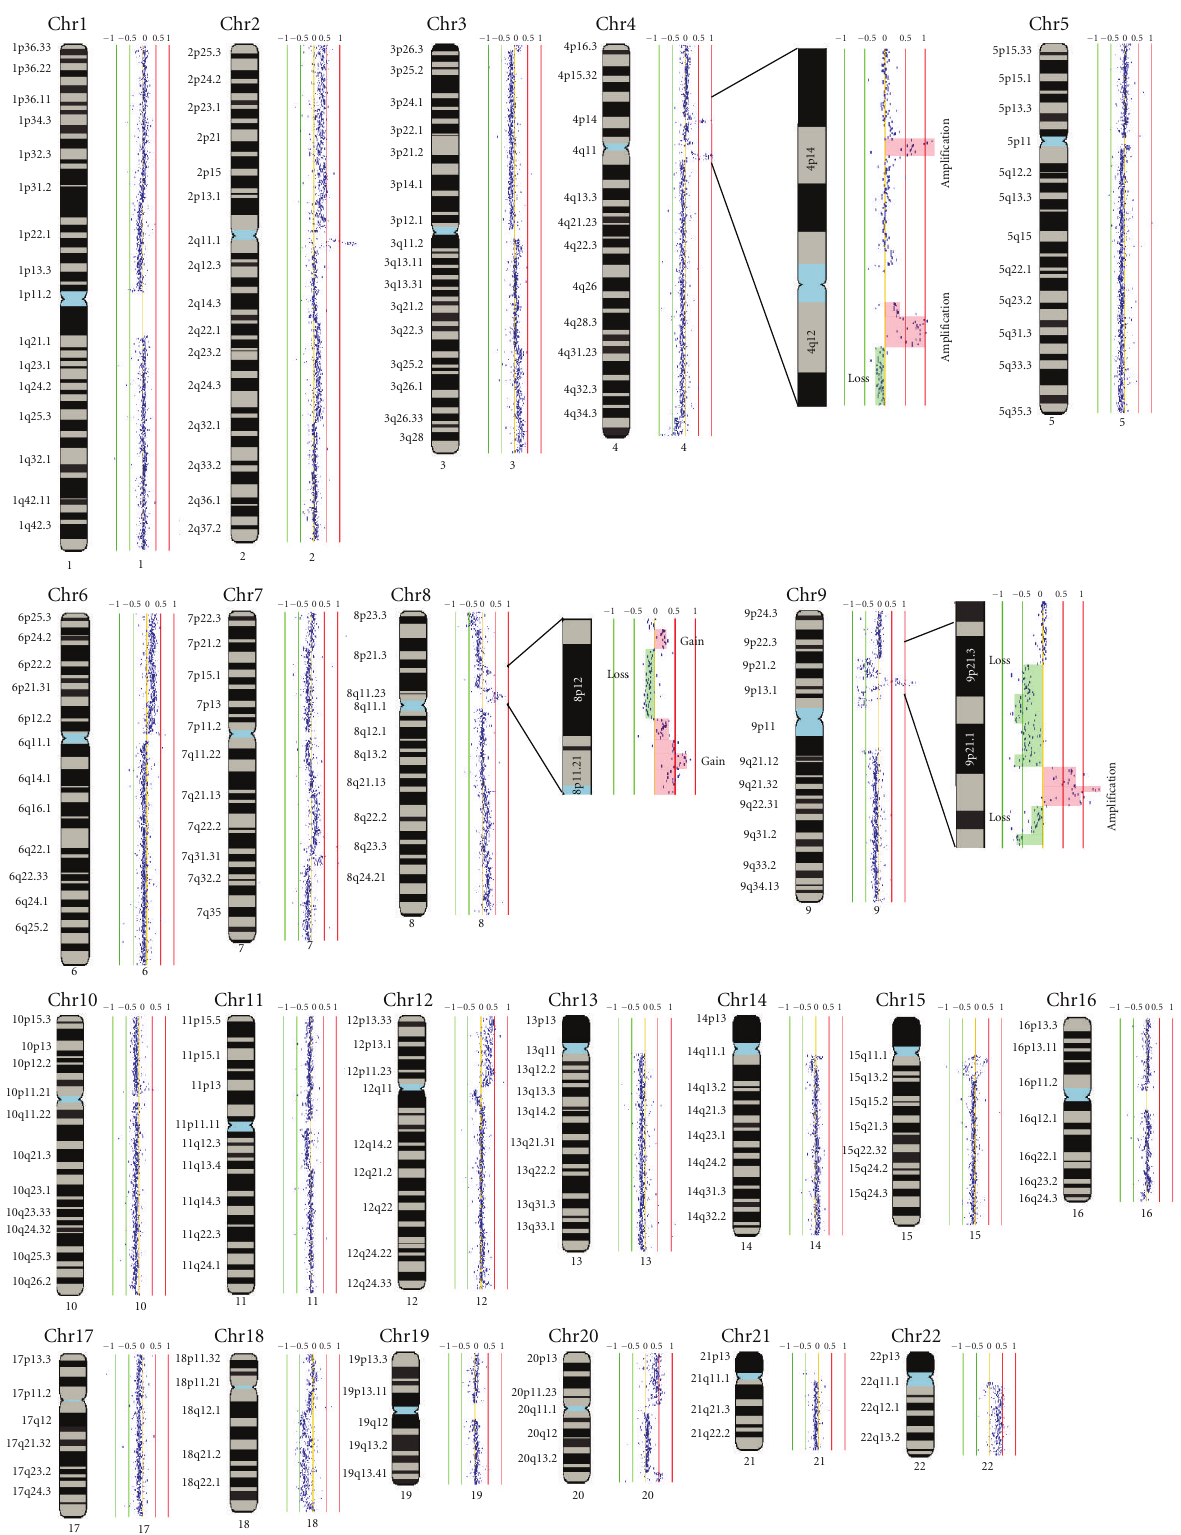
Figure 4: Whole-genome tiling-path array profile of an oral low-grade dysplasia. Normalized log2 signal intensity ratios were plotted using SIGMA software [85, 86]. Cytoband pattern corresponding to the data points was drawn to the left of each data plot. The red and green vertical lines represent signal intensity ratios from − 1 to +1 with an increment of 0.5. The magnified insets (for regions of chromosome 4, 8, and 9) include segmental copy number gain highlighted in orange and copy number loss highlighted